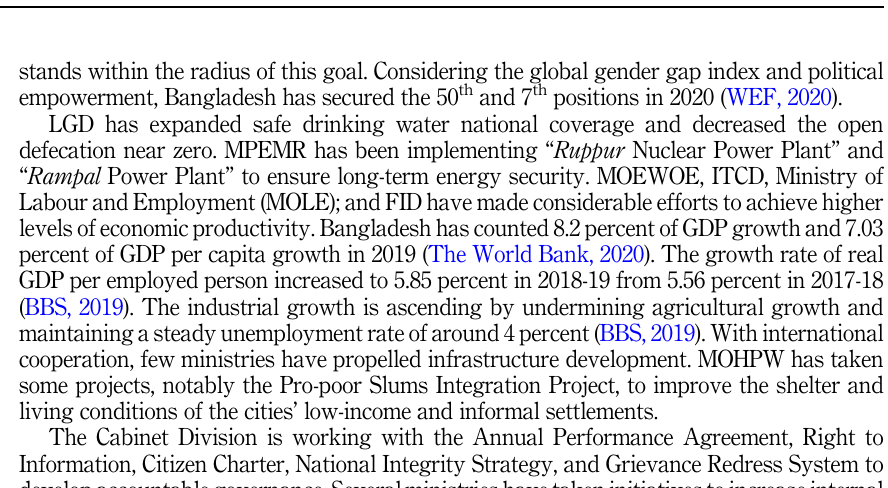
Table 3. List of SDGs ’